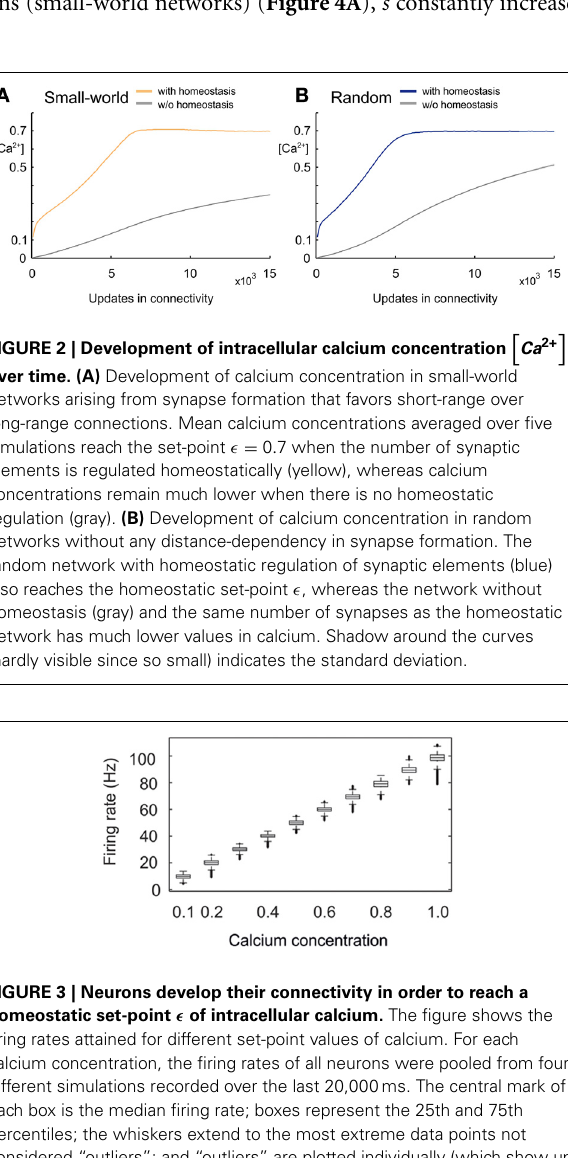
FIGURE 4 | Small-worldness of developing networks. (A) Small-world networks with (orange) and without (gray) homeostasis in electrical activity. (B) Random networks with (blue) and without (gray) homeostasis in electrical activity. Means over five simulations per scenario. Shadings of the curves indicate standard